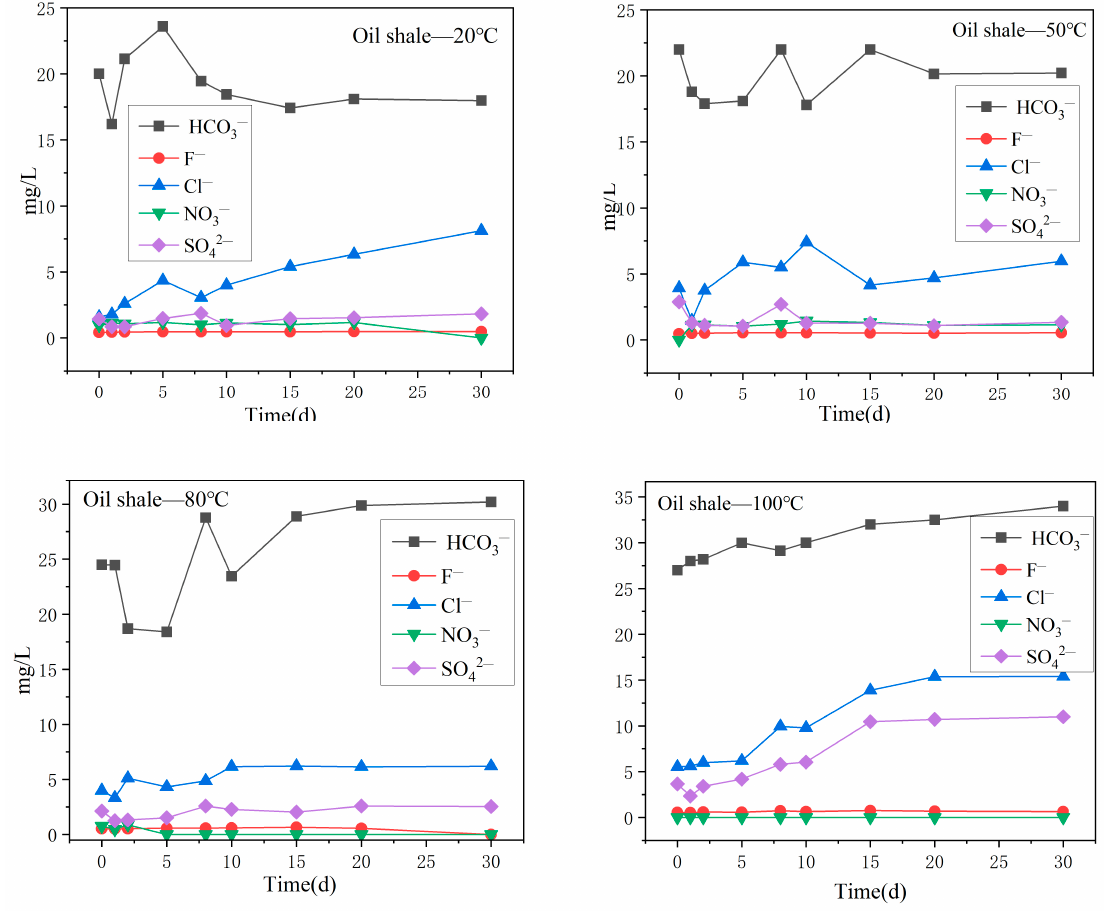
Figure 7. Variation in the content of the main anions in the oil shale aqueous solution under different temperature reaction conditions.